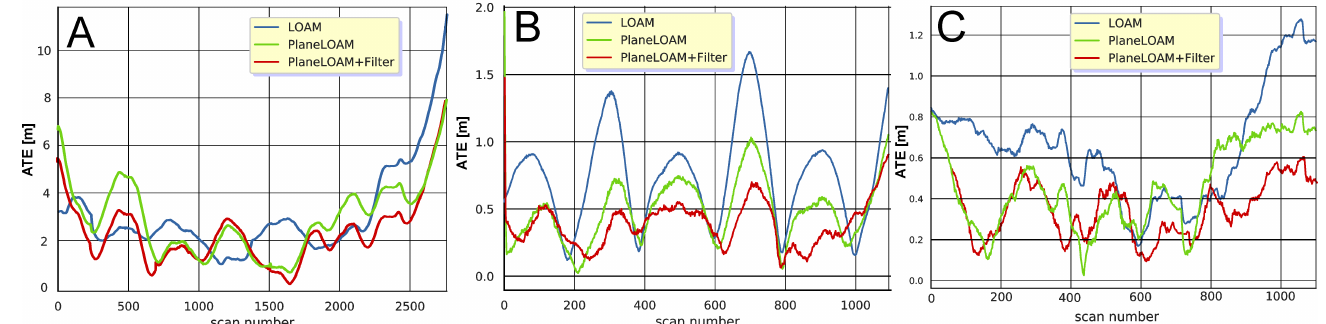
Figure 12. Plots of the ATE values as functions of the scan number for the three KITTI sequences used in evaluations 05 ( A ), 06 ( B ) and 07 ( C